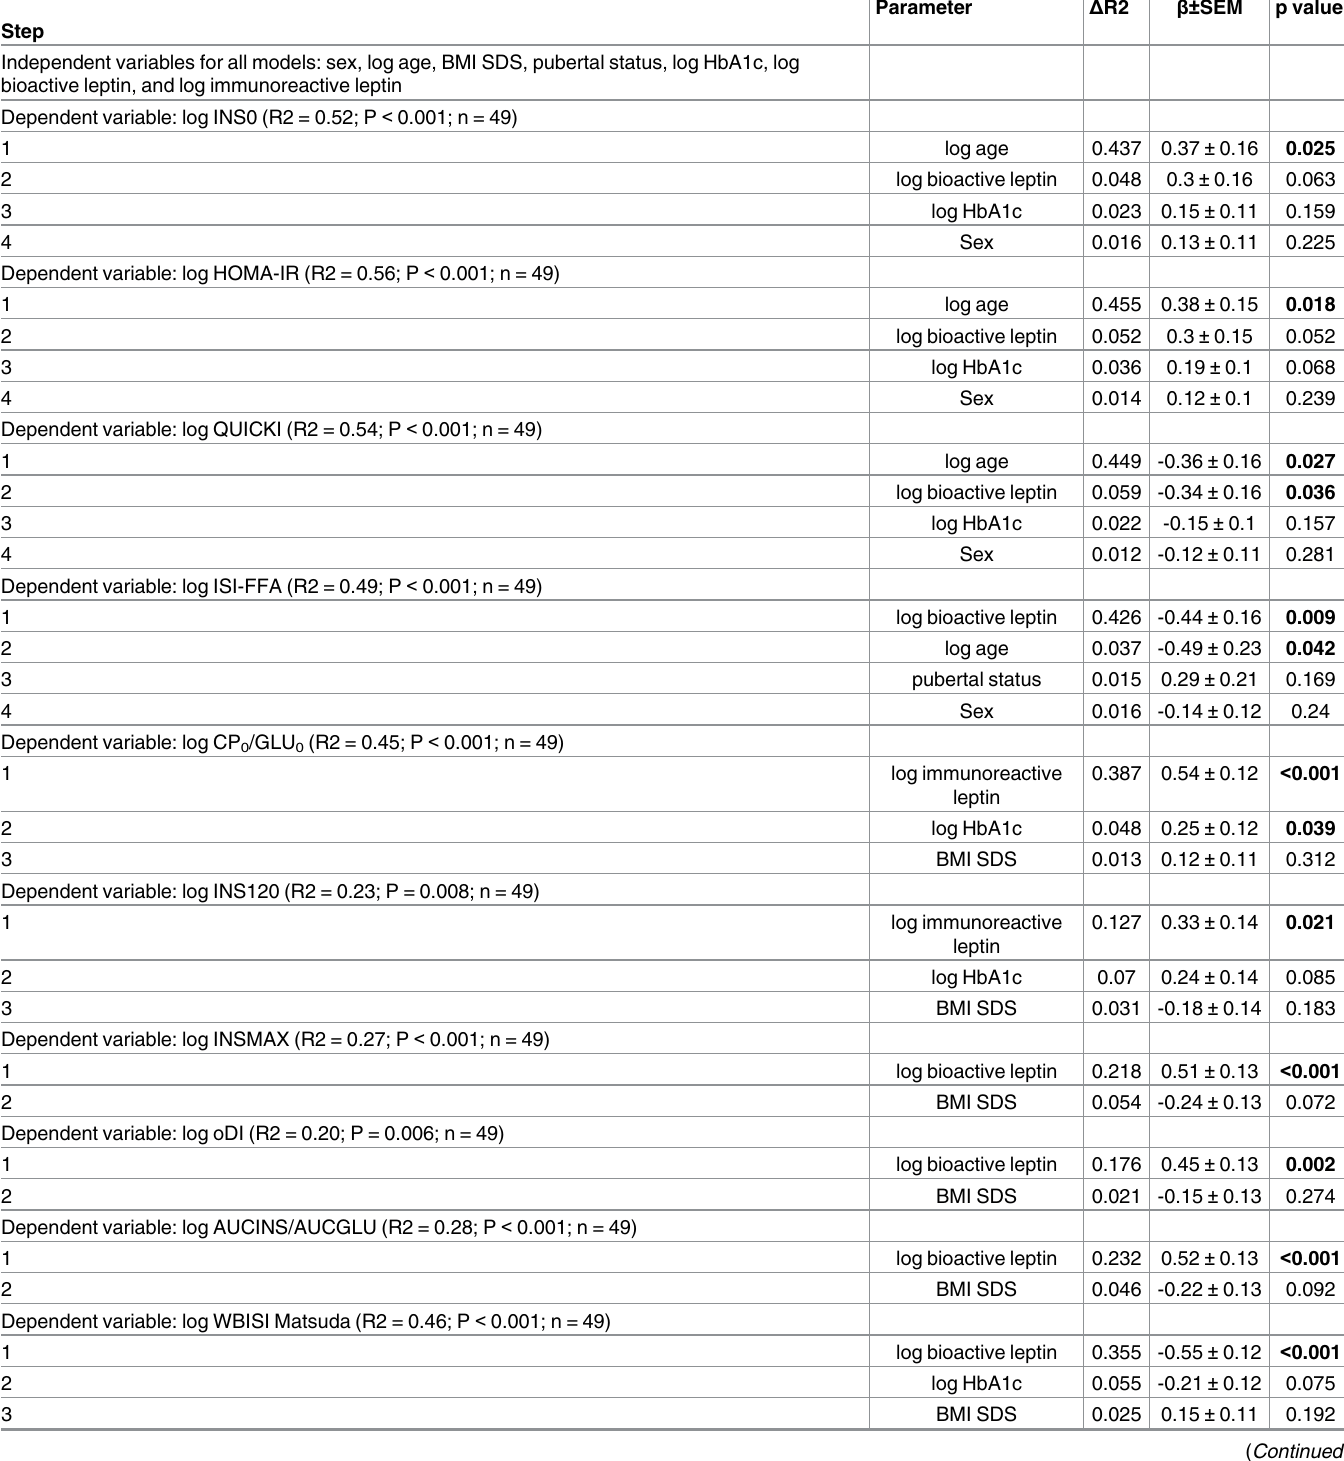
Parameter Δ R2 β± SEM p